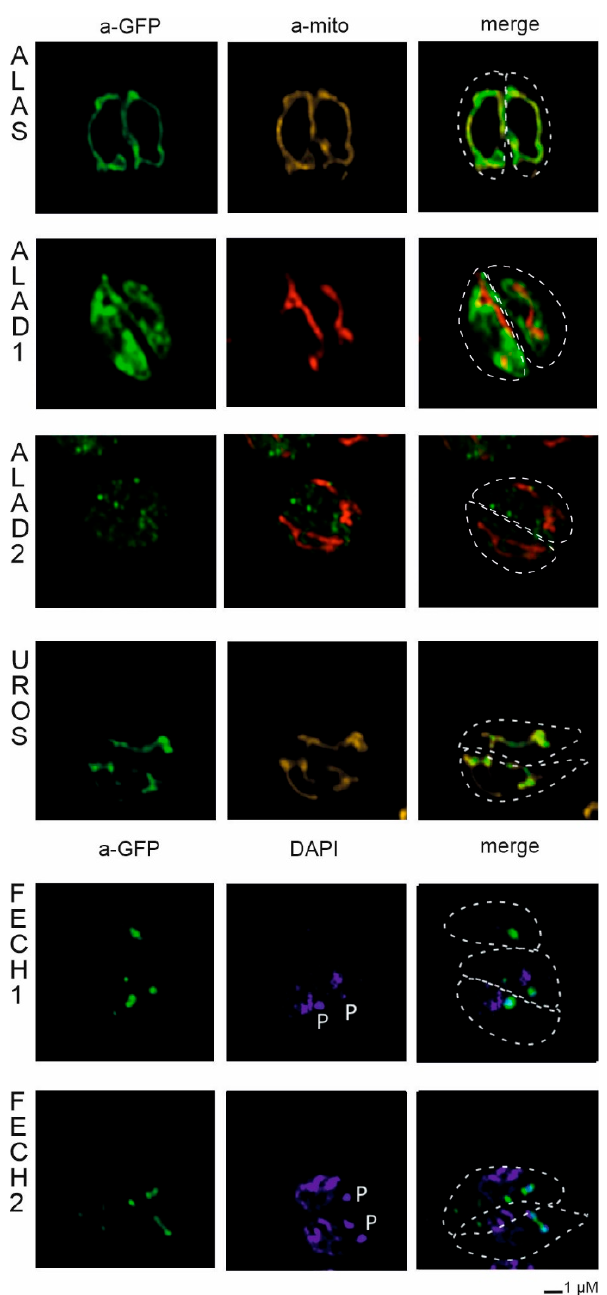
Figure 6. Heterologous expression of Toxoplasma gondii with genes from Chromera velia heme pathway enzymes. Immunofluorescence assays of transfected T. gondii , anti-GFP antibody were used to detect eYFP tagged C. velia enzymes. Anti-GFP (green) colocalized with mitochondrial anti-TgMys (a-mito, red and yellow) signal in case of ALAS and UROS. ALAD1 and ALAD2 signal were detected in the cytosol. FECH1 and FECH2 signal was found to overlap with DAPI (blue) signal at the area of parasite apicoplast. Apicoplast is denoted by “P”. Dashed line indicates T. gondii cell